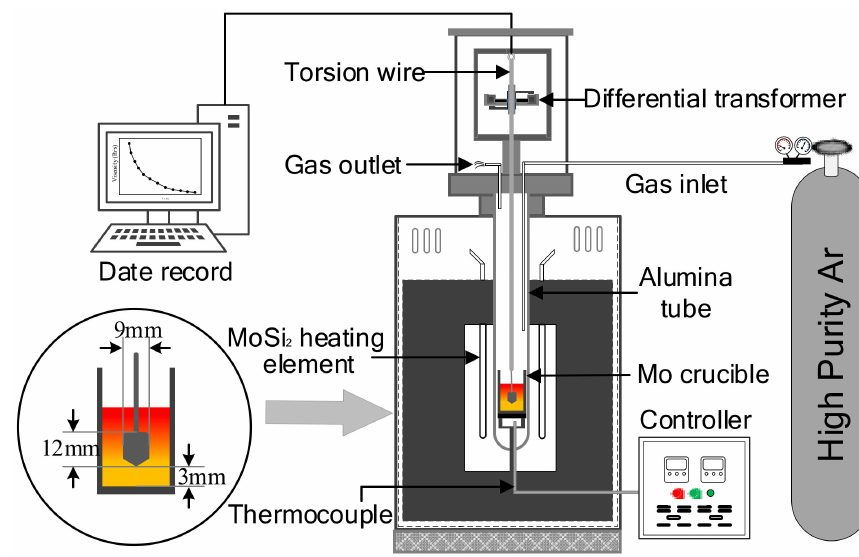
Figure 2. Experimental apparatus for the measurement of slag